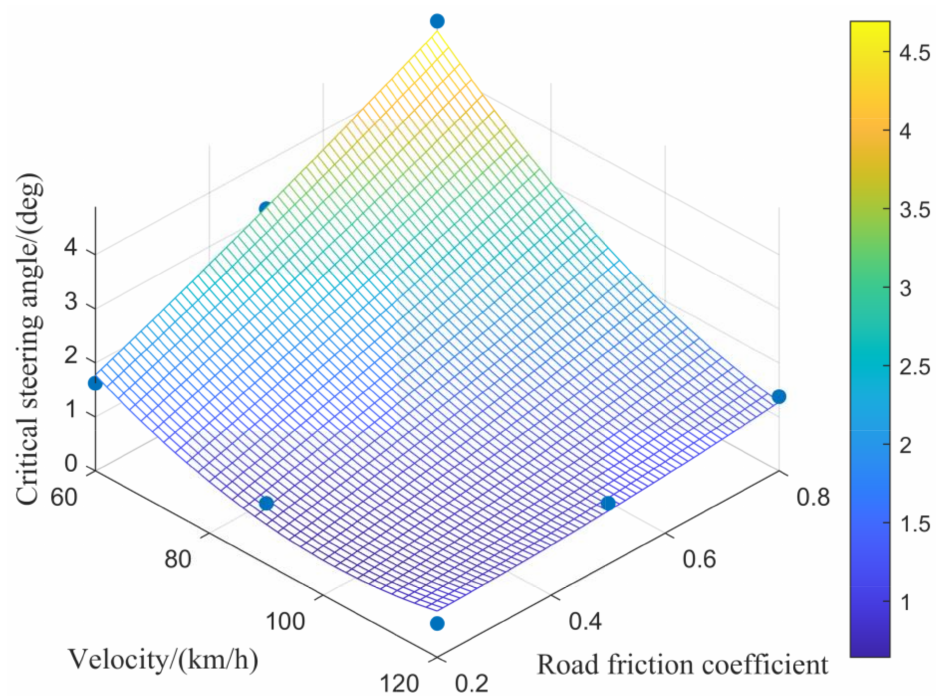
Figure 10. Illustration of the critical front wheel steering angle at different velocities and different road friction